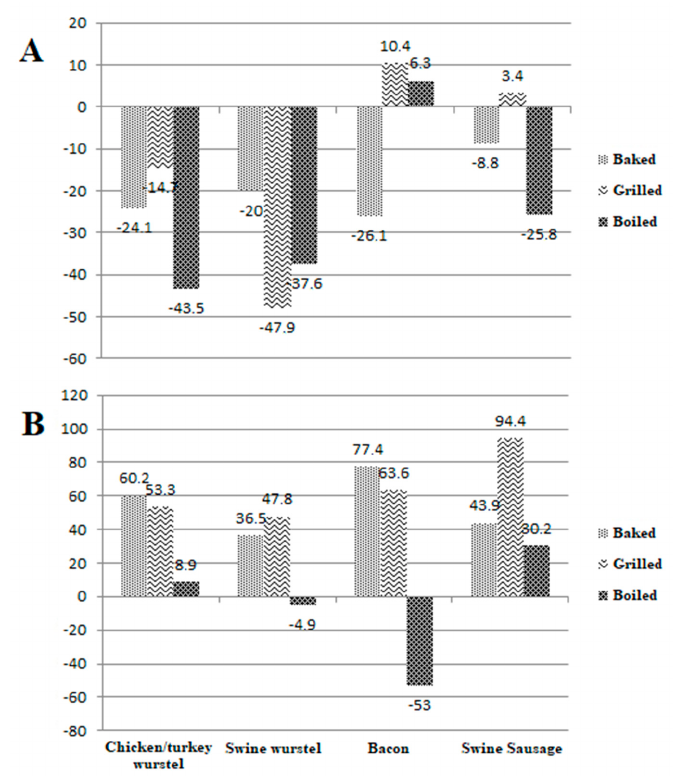
Figure 5. Graphical visualization of mean variations % in nitrite ( A ) and nitrate ( B ) concentrations in 60 samples of meat products after three different types of cooking